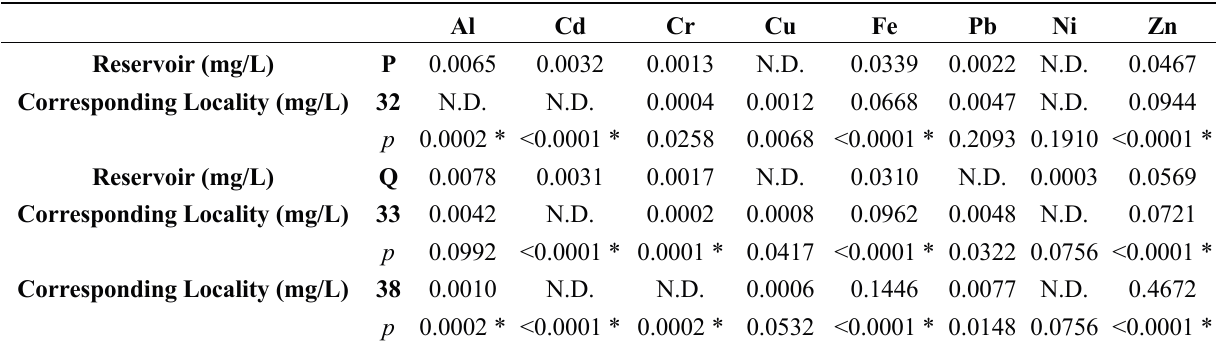
Table A14. Statistical variation between Reservoirs P, Q and their feeding Localities 32 and 33, 38. Al Cd Reservoir (mg/L) P Corresponding Locality (mg/L)